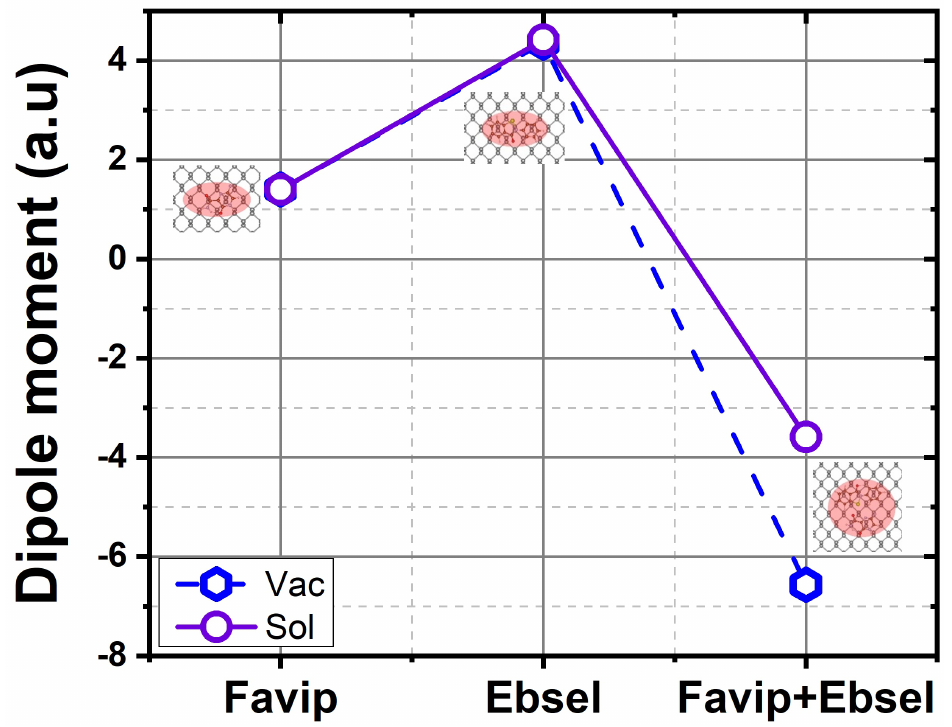
Figure 6. The calculated dipole moment of BP sheet with favipiravir, ebselen, and favipiravir+ebselen hybrid molecules in a vacuum (blue) and with solvent (purple),